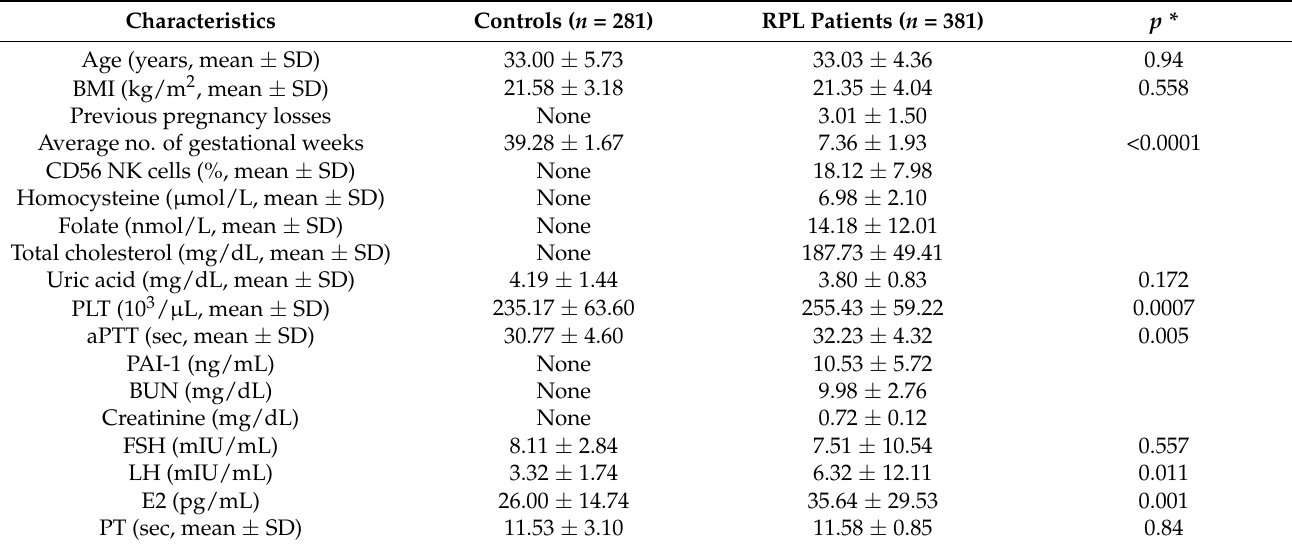
Table 1. Baseline characteristics of recurrent pregnancy loss patients and control